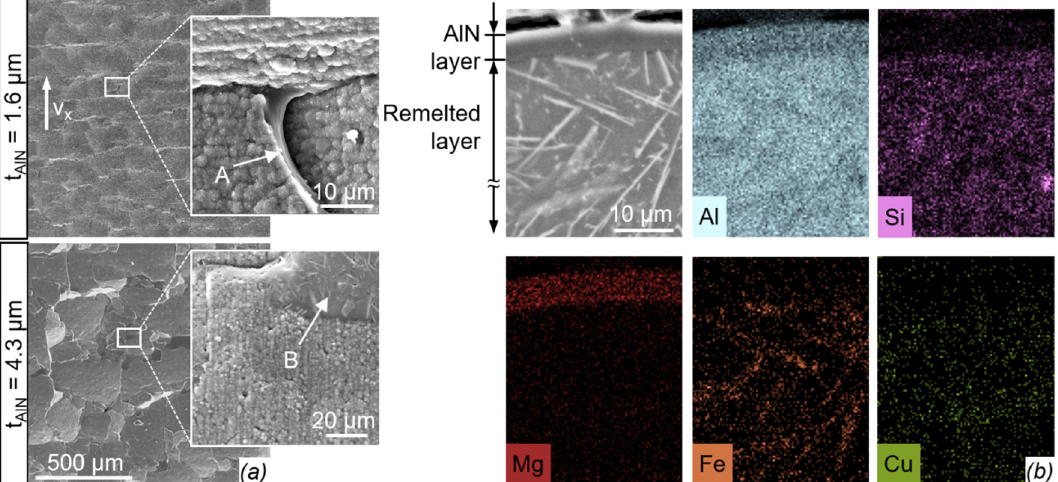
Figure 3. Influence of EBR (line scan; vx = 12 mm/s; I B = 10 mA) on ( a ) the surface topography in the light optical cross section ( Δ h x … height difference), and ( b ) the microstructure (SEM-SE contrast).